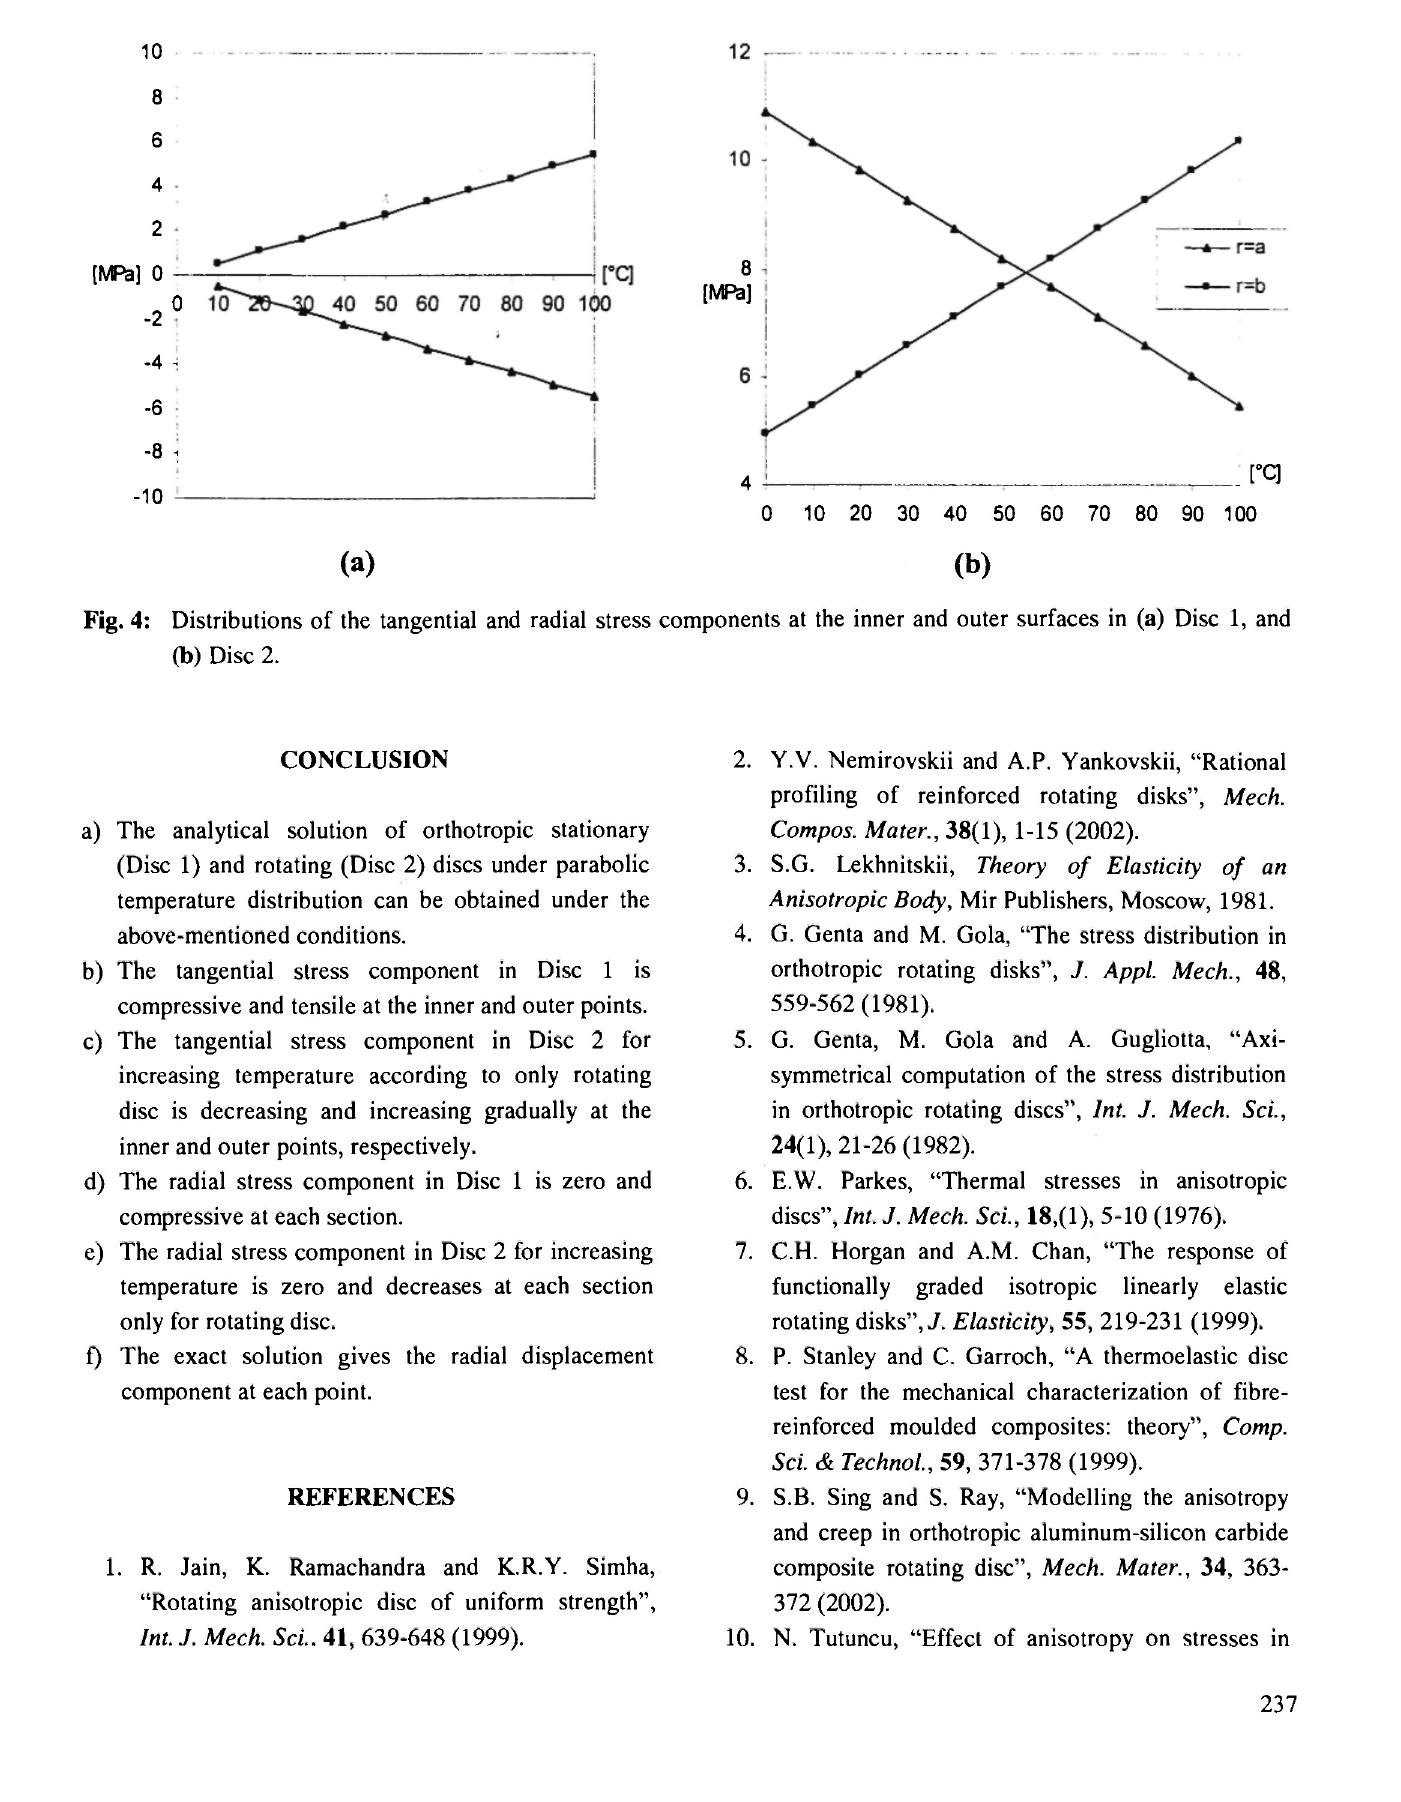
components at the inner and outer surfaces in (a) Disc 1,